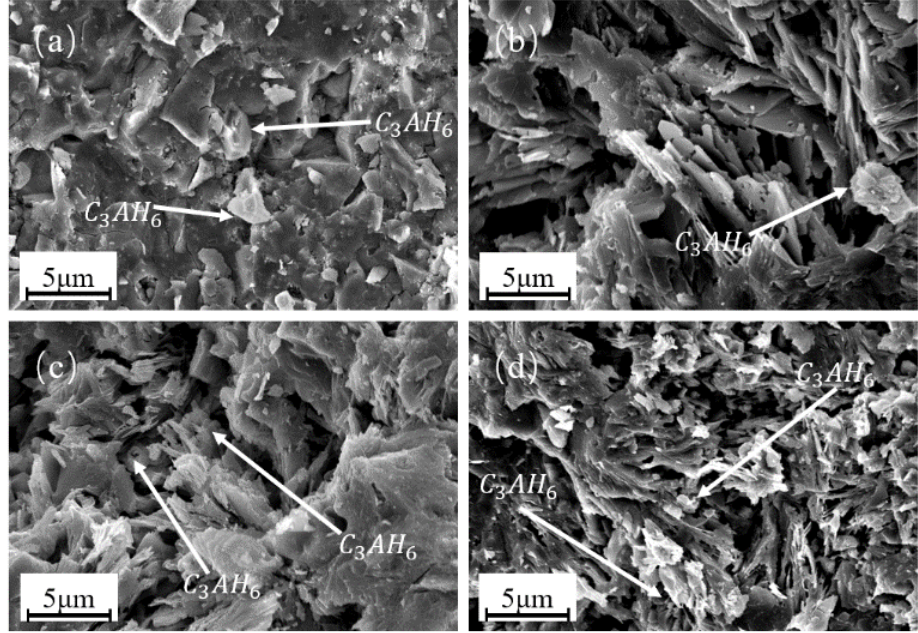
Figure 8. Scanning electron microscopy (SEM) images of PCAC after 1 d of hydration: ( a ) without STPP, ( b ) with 0.05% STPP, ( c ) with 0.1% STPP, and ( d ) with 0.2% STPP.